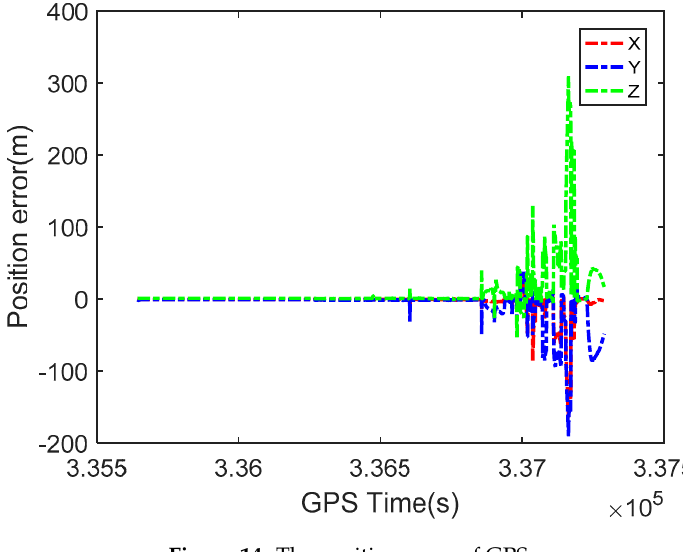
Figure 14. The position error of GPS.